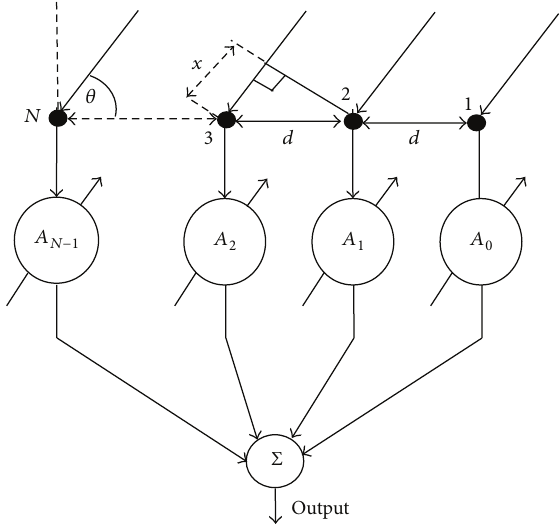
Figure 1: Uniform linear array of 𝑁 elements with 𝑁 − 1 steerable